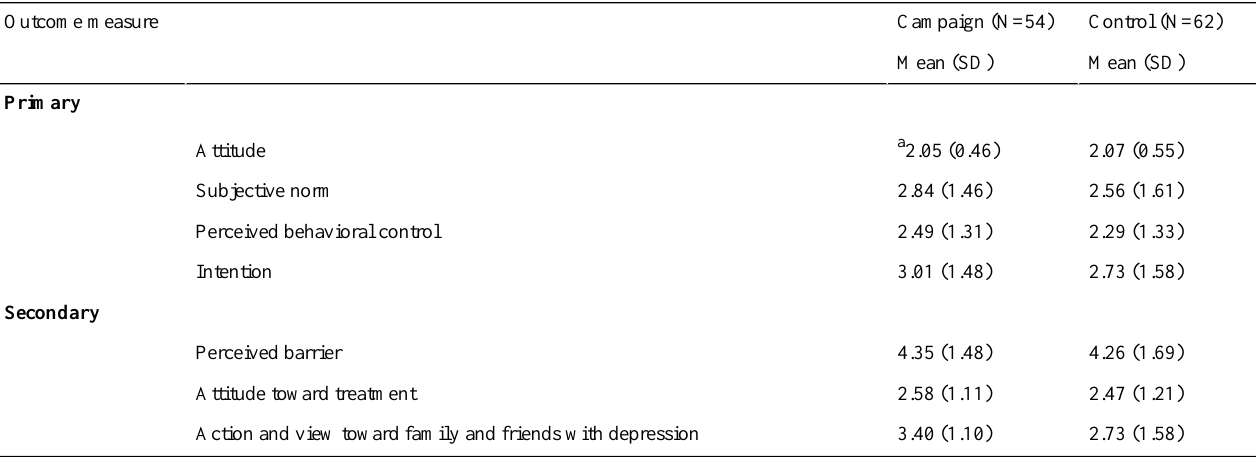
Table 2. Posttest scores of the primary and secondary outcome measures of the help-seeking models in the campaign and control groups.